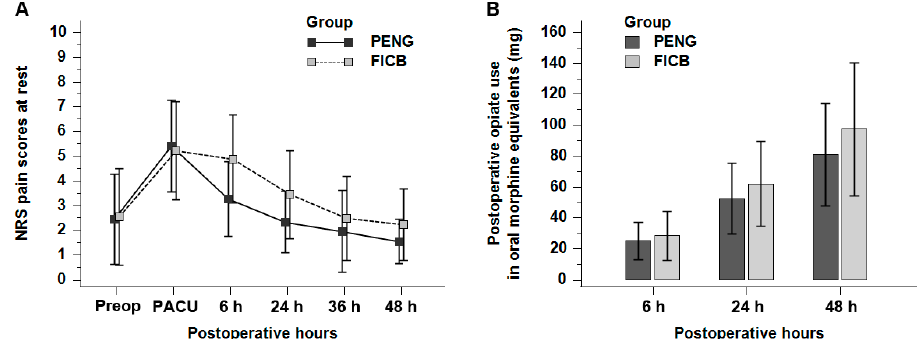
Figure 3. Pain intensity and opioid consumption: ( A ) NRS pain scores at rest over time. Data are expressed as mean ± standard deviation; ( B ) total opioid use over time. The bar chart displays the mean cumulative opioid consumption with standard deviation (error bars) at 6, 24, and 48 h following surgery. FICB, supra-inguinal fascia iliaca compartment block; NRS, numeric rating scale; PACU, postanesthesia care unit; PENG, pericapsular nerve group block. Table 2. Postoperative pain scores and opioid consumption